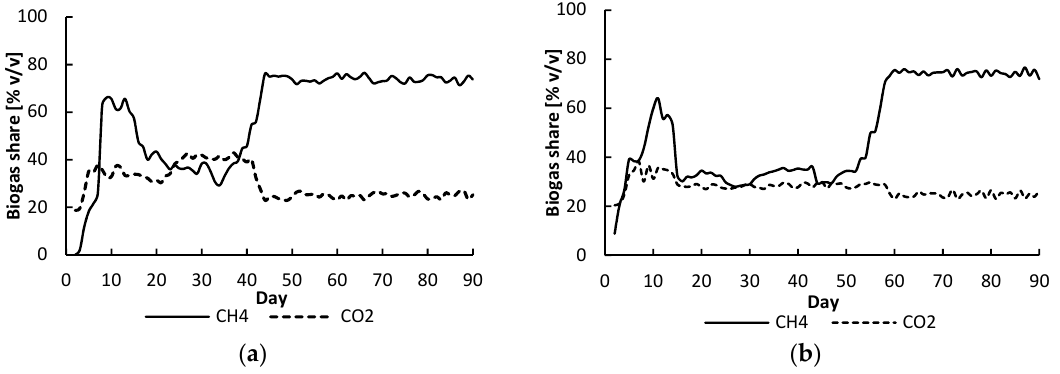
Figure 4. Changes in the biogas composition during the anaerobic digestion of ORF; ( a ) mesophilic—temperature 37 °C, ( b ) thermophilic—temperature 55 °C.